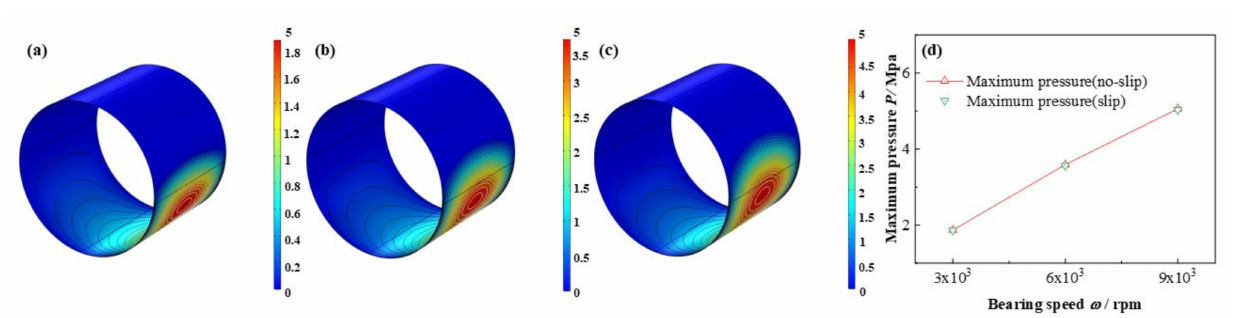
Figure 18. Comparison of the pressure distribution under different bearing speeds. ( a ) ω = 3 × 10 3 rpm; ( b ) ω = 6 × 10 3 rpm; ( c ) ω =9 × 10 3 rpm; ( d ) minimum pressure.